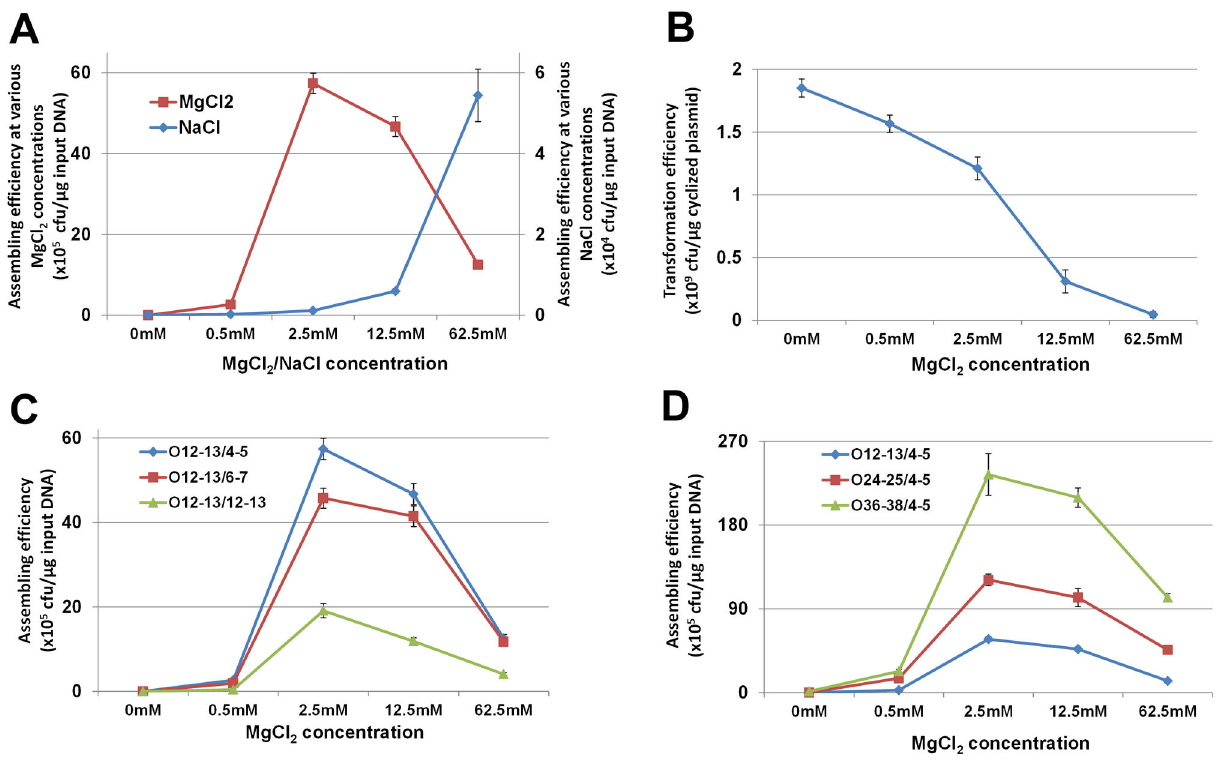
Figure 2. The cross-lapping in vitro assembly (CLIVA) method. (A) Illustration of the design at one junction between two modules (blue and red). The cross-lapping primer consists of gene specific sequence (GSS) and tag sequence complementary to adjacent primer’s GSS. The phosphorothioate modifications were indicated as cycles. An “Ox/y” designation was used to define the primers, where O denoted overlap; x was the length of overlap which had one modification at each y base pairs of the sequence. (B) Illustration of assembling of multiple DNA modules into one